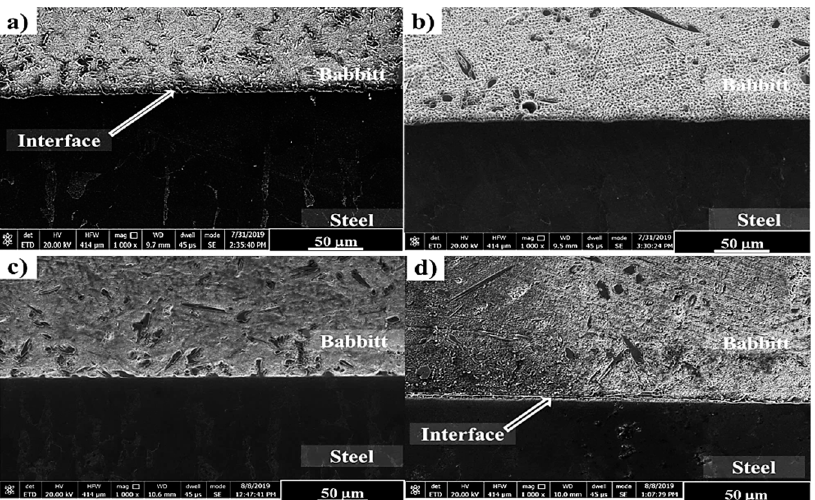
Figure 6. SEM images of interfaces in tin-based Babbitt/steel bimetallic cast specimens with different loading fraction of alumina nanoparticles in tin-based Babbitt alloy: ( a ) 0 wt %, ( b ) 0.25 wt%, ( c ) 0.50 wt% and ( d ) 1.0 wt%.